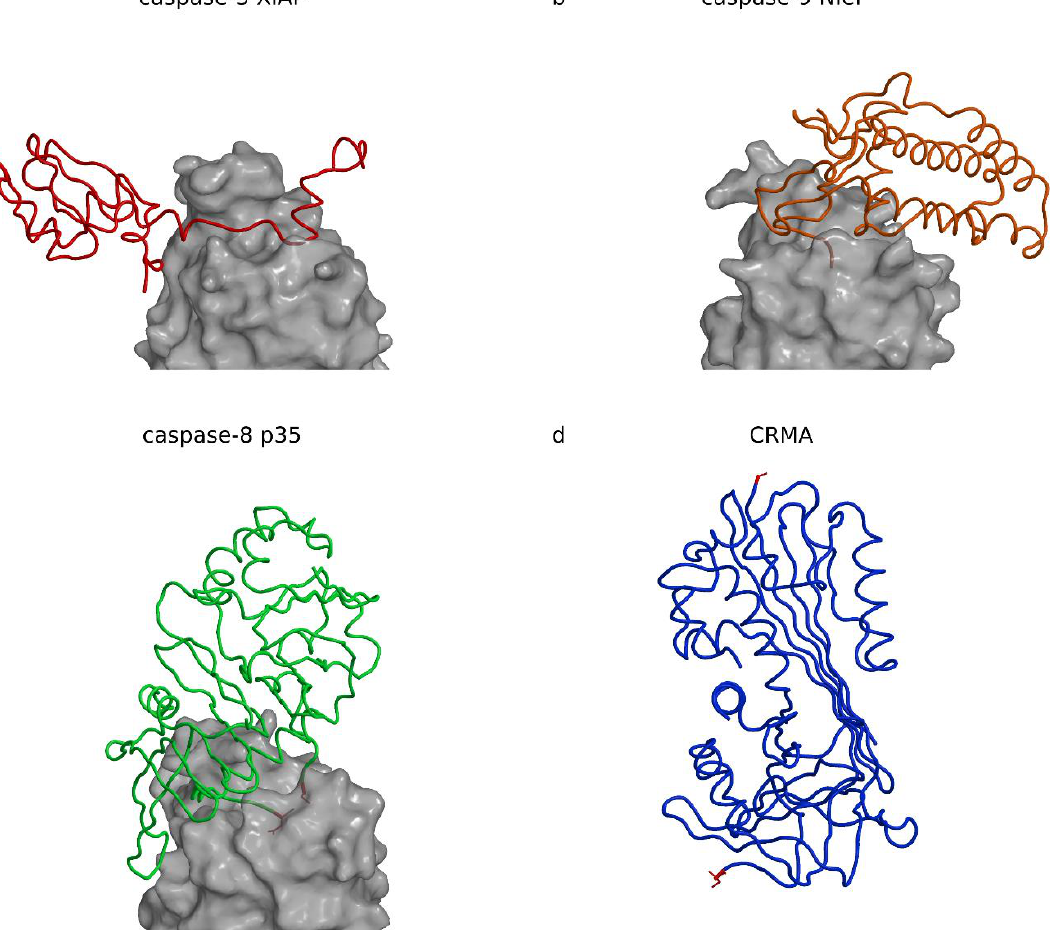
Figure 2. Inhibitors of caspases. Complexes are shown with the same view and scale aligned after superimposition of the caspases to the caspase-3 in the complex with X-linked inhibitor of apoptosis (XIAP). Figure was prepared using MAIN [35] [82] and rendered with Raster3d [36]. ( a ) Human XIAP caspase-3 complex ([83], PDB code 1I3O). The XIAP chain is shown as a red coil on the semitransparent background of the white surface of caspase-3. ( b ) Escherichia coli Nlef caspase-9 complex ([84], PDB code 3V3K). The Nlef chain is shown as an orange coil on the semitransparent background of the white surface of caspase-9. ( c ) Baculovirus p35 caspase-8 complex ([85], PDB code 1I4E). The p35 chain is shown as a blue coil on the semitransparent background of the white surface of caspase-8. ( d ) The CrmA chain ([86], PDB code 1F0C) is shown as a blue coil with the cleaved residues A359 and S359A shown as stick model in red.